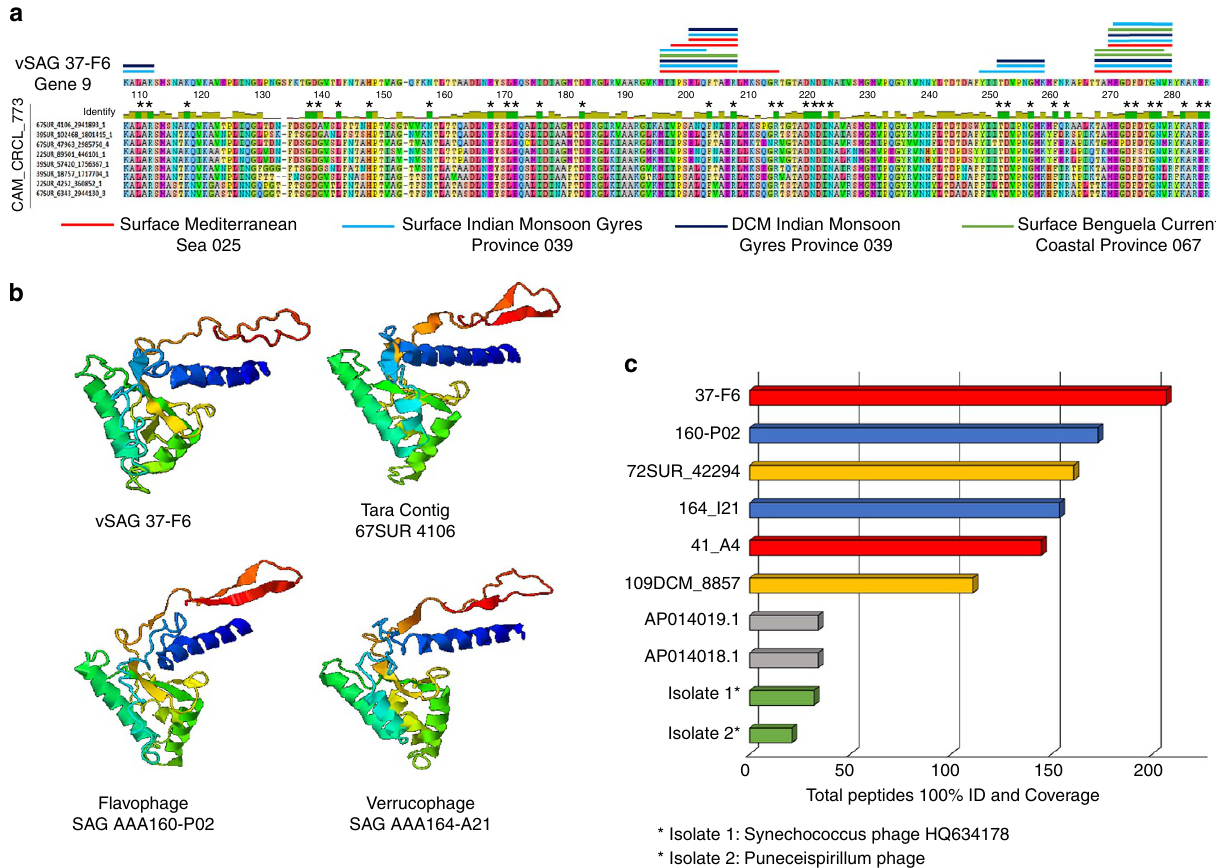
Figure 5 | Capsid protein of vSAG 37-F6 and abundance in proteomic Tara viral data set. ( a ) Peptide alignment of vSAG 37-F6 with the capsid proteins of cluster CAM_CRCL_773. For convenience, we only show eight protein sequences out of 152 total capsid proteins. Coloured lines above amino-acid sequence of vSAG 37F6 represent the perfect matches of predicted peptide sequences from Tara expedition 31 (100% identity similarity and query coverage). Colour denotes the origin of peptides. Conserved amino-acid positions in the protein alignment are denoted with ‘*’ ( b ) Representative 3D-structural model, using I-TASSER prediction server, of the 37-F6 capsid protein compared with the nearest viral capsid proteins: the Tara Contig 67SUR_4106 and viruses from SAGs AAA160-P02 ( Flavobacteria ) and AAA164-I21 ( Verrucomicrobia ). ( c ) Number of total recruited peptides from Tara expedition 31 (100% identity and query coverage) for the top two most recruiting viruses from each viral genomic data set 3,10,26